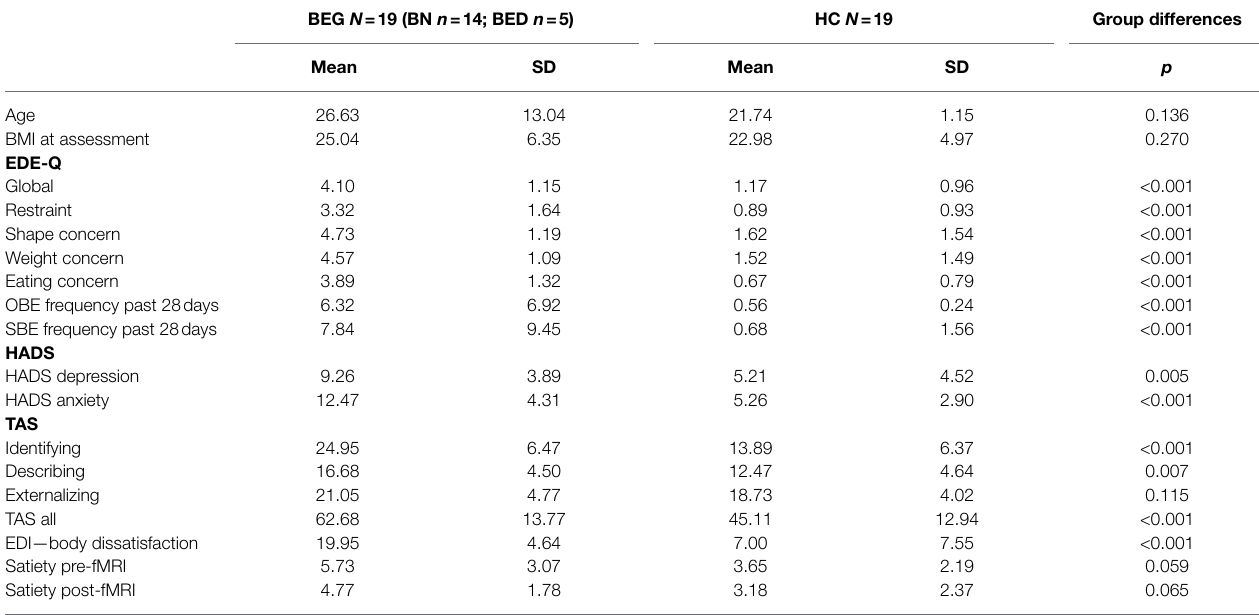
TABLE 1 | Participant information and assessment